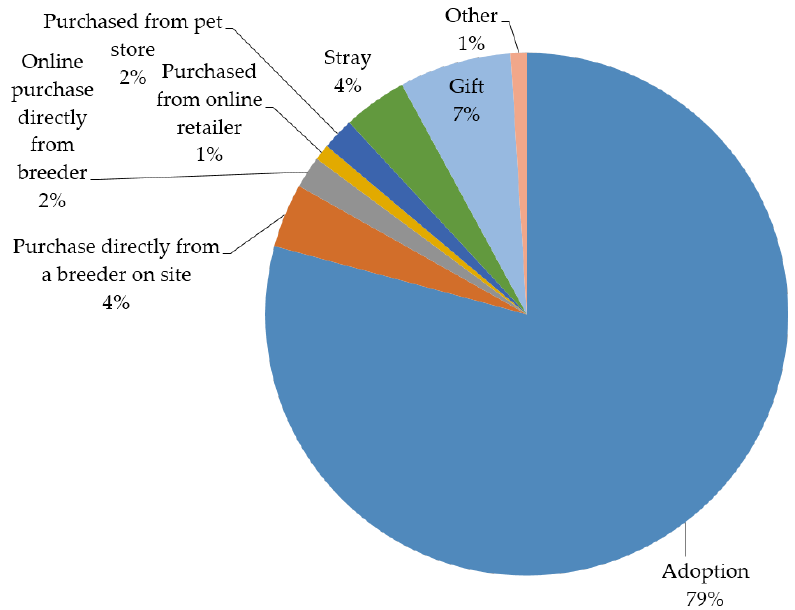
Figure 1. RPL preference shares for relative ranking of the perceptions of ethical acquisition methods by respondents.